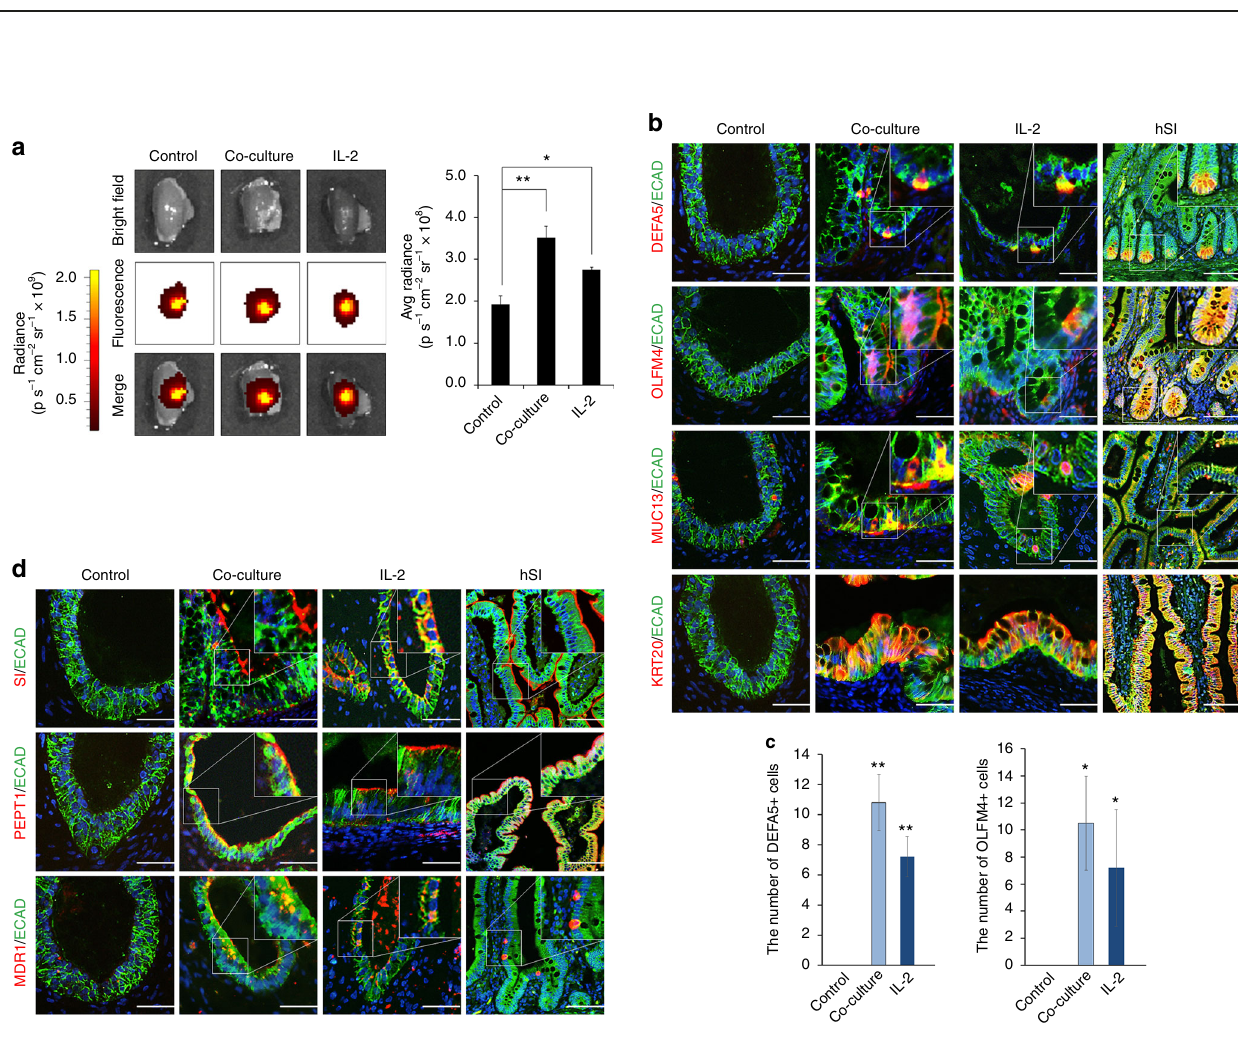
Fig. 4 In vitro-matured hIOs have signi fi cantly enhanced functionalities. a Comparison of the gene expression of drug-metabolizing enzymes (phase I/II enzymes) and intestinal transporters (ABC transporters and SLC transporters) among hIOs, hAT-IOs, and hSI. The graph represents the number of genes with expression >2-fold when compared with the control hIOs. b Hierarchical clustering of the expression level of genes encoding intestinal enzymes and transporters in control, co-cultured, and IL-2-treated hIOs, hAT-IOs, and hSI. c Paracellular permeability of hIOs incubated with 4 kDa FITC-Dextran and 40 kDa FITC-Dextran. Scale bar, 1 mm. d Expression levels of the transporter P-gp ( MDR1 , ABCB1 ) relative to control hIOs as assessed by qPCR (left panel). Apical concentration of paclitaxel following 2 h incubation in the absence or presence of verapamil in control, co-cultured or IL-2-treated hIOs (right panel, n = 20 per group). e Expression levels of the glucose transporters ( GLUT2 , GLUT5 , SGLT1 ) in control, co-cultured, IL-2 treated hIOs, and hSI as assessed by qPCR (left panels). Glucose-induced Ca 2 + transients in real-time manner in control, co-cultured and IL-2 treated hIOs (middle panels). Mean values of peak fl uorescence intensity by using Fluo-4-AM calcium indicator (right panel) ( n = 15 per group). f Expression levels of the CFTR in control, co-cultured, IL-2 treated hIO and hSI as assessed by qPCR (left panel). Representative images of the morphological changes of hIOs after treatment with forskolin (middle panel). Scale bar, 200 μ m. Normalized forskolin-induced swelling of control, co-cultured, and IL-2 treated hIOs with or without CFTR inhibitors (GlyH101 + CFTR inh 172) (right panel, n = 4 per group). g Mucicarmine staining for secreted mucin and acid mucopolysaccharide (black arrowheads), and PAS staining for the mucous layer (black arrows) and mucous producing goblet cells. Scale bar, 50 μ m. h Expression levels of intestinal hormone GIP of control, co-cultured, and IL-2 treated hIOs and hSI (left panel). The levels of secreted GIP from enteroendocrine cells in hIOs ELISA for detection of, and normalized to DNA content (right panel). Data are presented as mean values of replicates ± SEM. *** p < 0.001 according to t -test